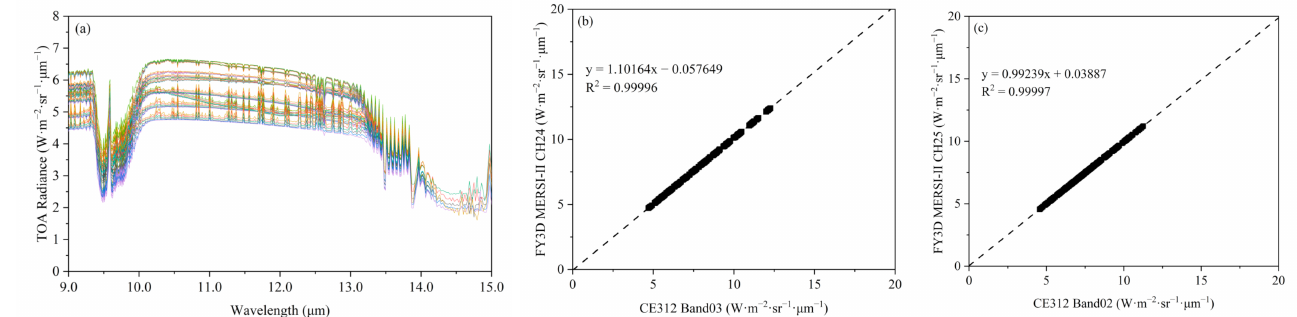
Figure 5. Spectral matching for thermal infrared channels of the FY − 3D MERSI-II with the corresponding bands of the CE312–1N ( b , c ) by convolving the top-of-atmosphere (TOA) radiance ( a ) with the relative spectral response (RSR).